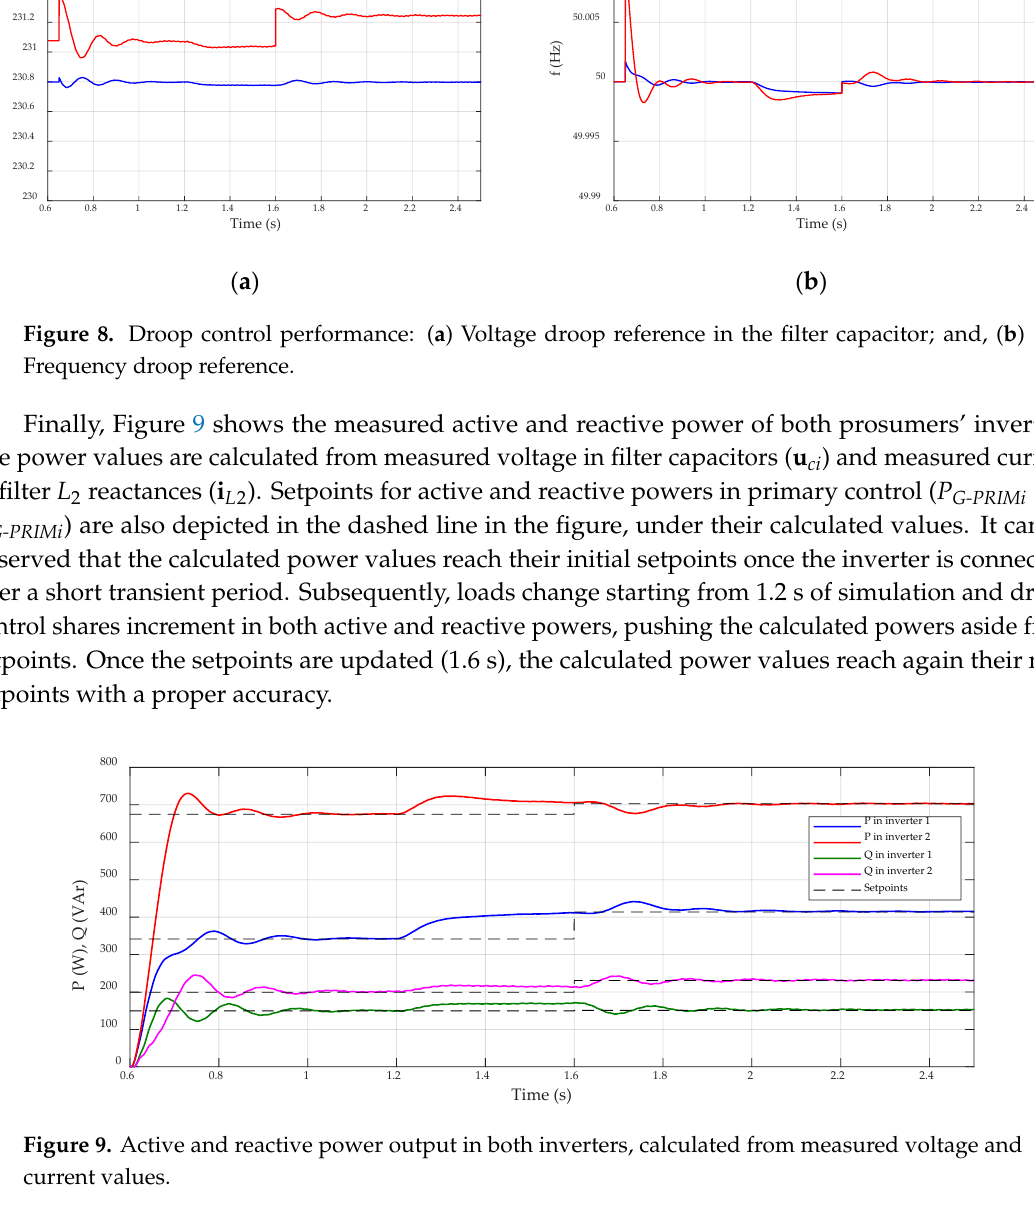
Figure 7. Voltage in the load bus and current in both reactances of converter LCL filter: ( a ) Prosumer 1; ( b ) Prosumer 2.